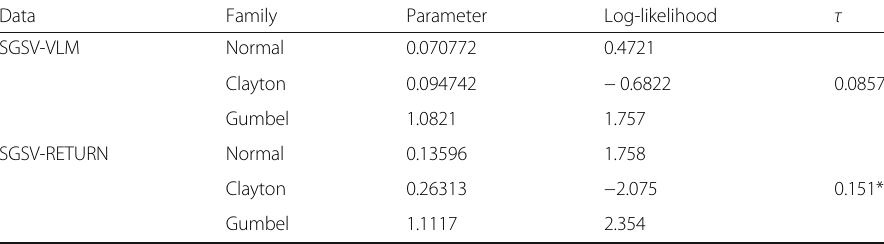
Table 5 Copulas estimation results for two pairs Data